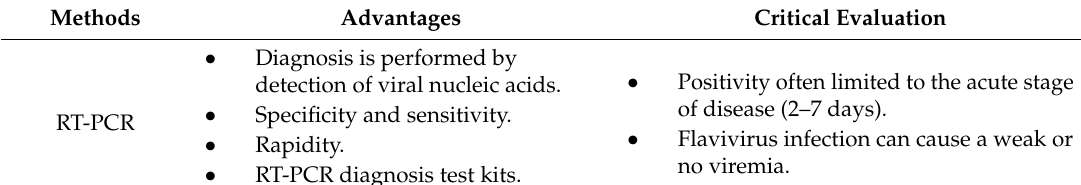
Table 1. Current laboratory techniques for the diagnosis of acute human flavivirus